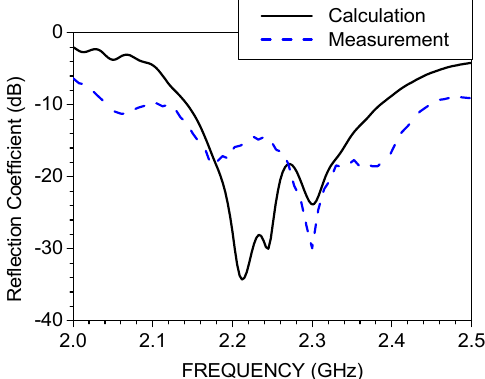
Figure 5. Reflection coefficients of the 16 by 1 antenna subarray.